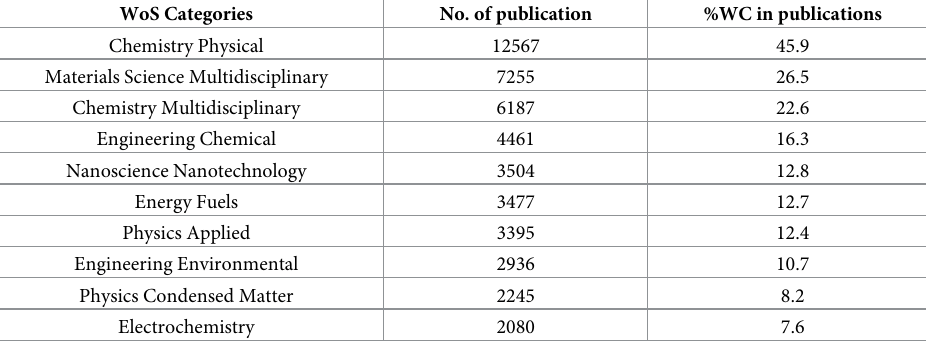
Table 1. The publications of WoS subject categories (Top 10).